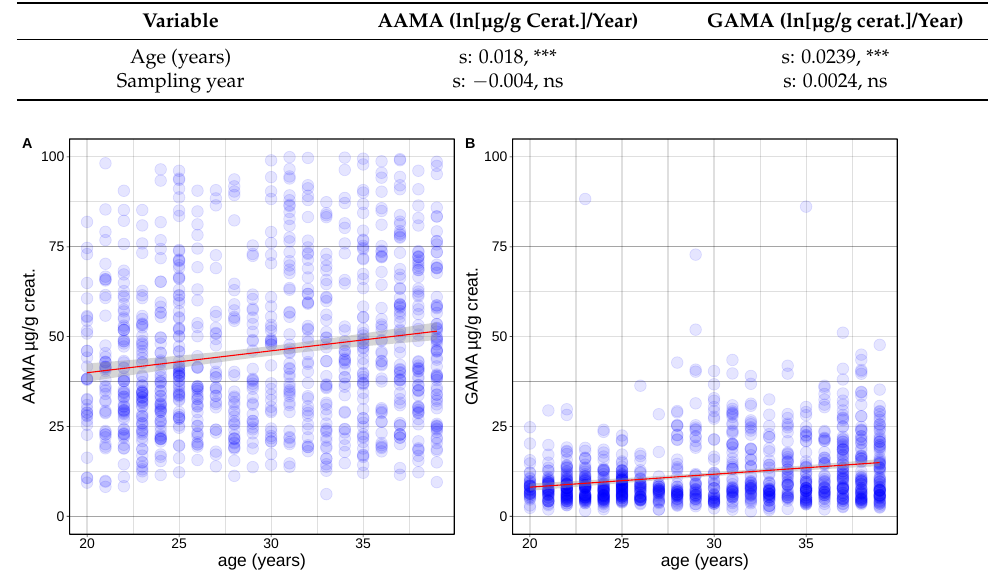
Table 4. Estimated slope (s) and statistical significance of a multiple linear regression for AAMA and GAMA in µg/g creatinine (after normalization by logarithmic transformation using natural logarithm, ln) and age in years in adults. ***: p < 0.001, ns = not significant.